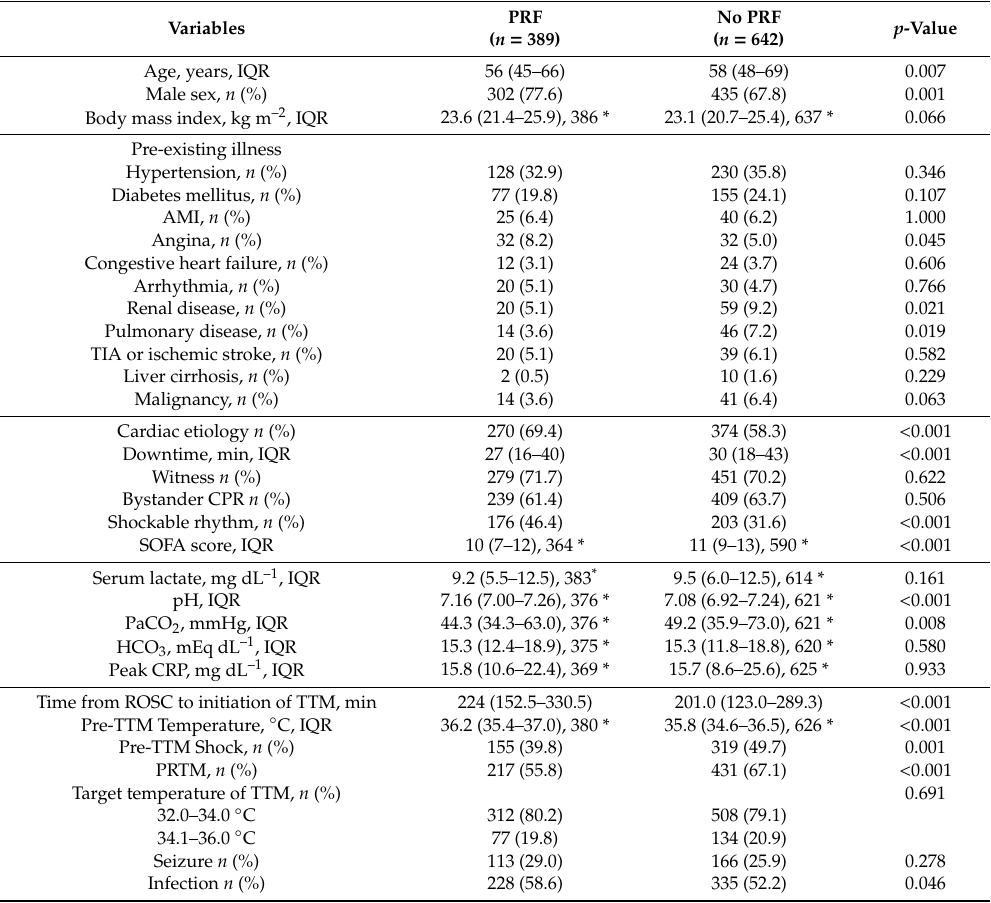
Table 2. Demographics and characteristics of the included patients according to post-rewarming